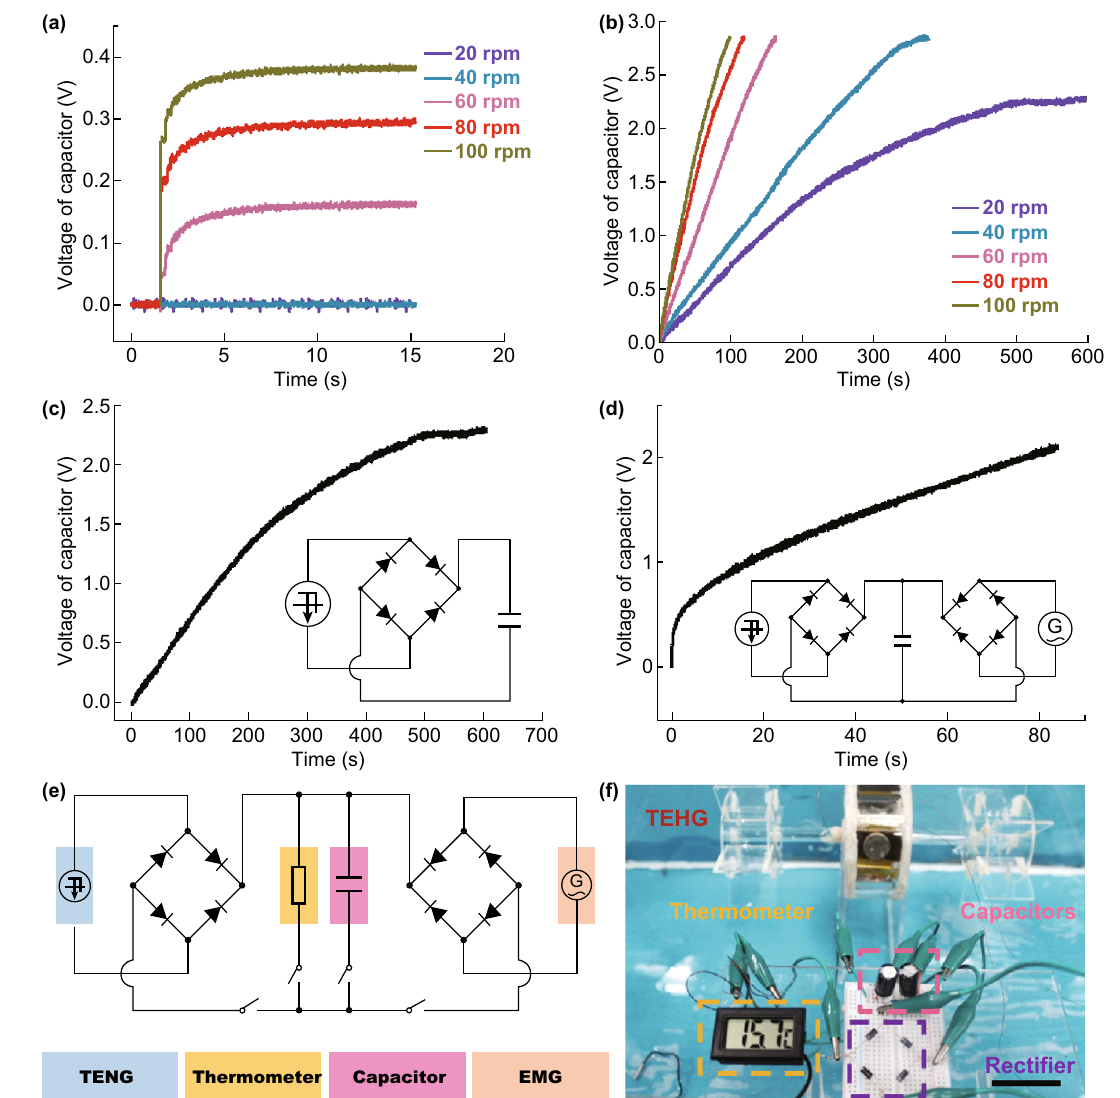
Fig. 4 Distinctive and combined performances of the RF-EMG and CS-TENG. Measured voltages of a 33 l F capacitor charged by a the RF- EMGs and b the CS-TENGs at a rotation speed ranging from 20 to 100 rpm. Measured voltages of a 33 l F commercial capacitor charged by the TEHG under two different working conditions: c at 40 rpm and d at 100 rpm. The inset shows the circuit diagrams. e Circuit diagram of a self- powered water-temperature sensing system. f Photograph of the self-powered water-temperature sensing system, including the TEHG, rectifier, capacitors, and electronic thermometer (scale bar: 4